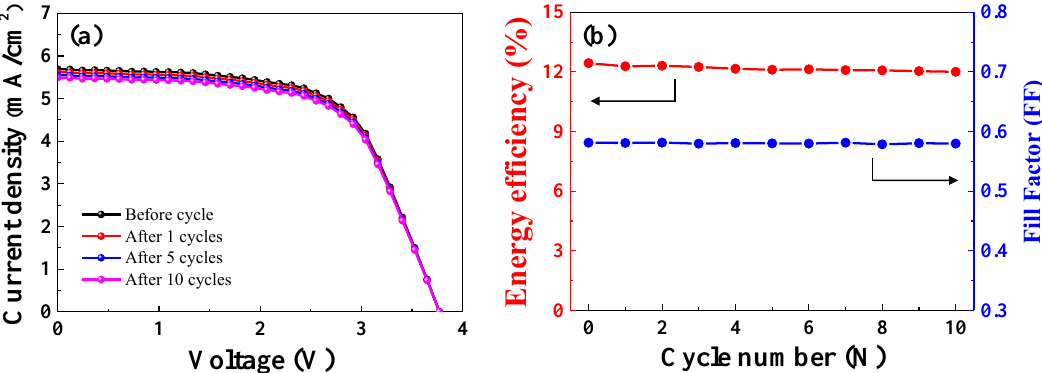
Figure 10. J-V curve ( a ) and energy efficiency and fill factor ( b ) of the PCSs connected to the LIB before and after various cycles.